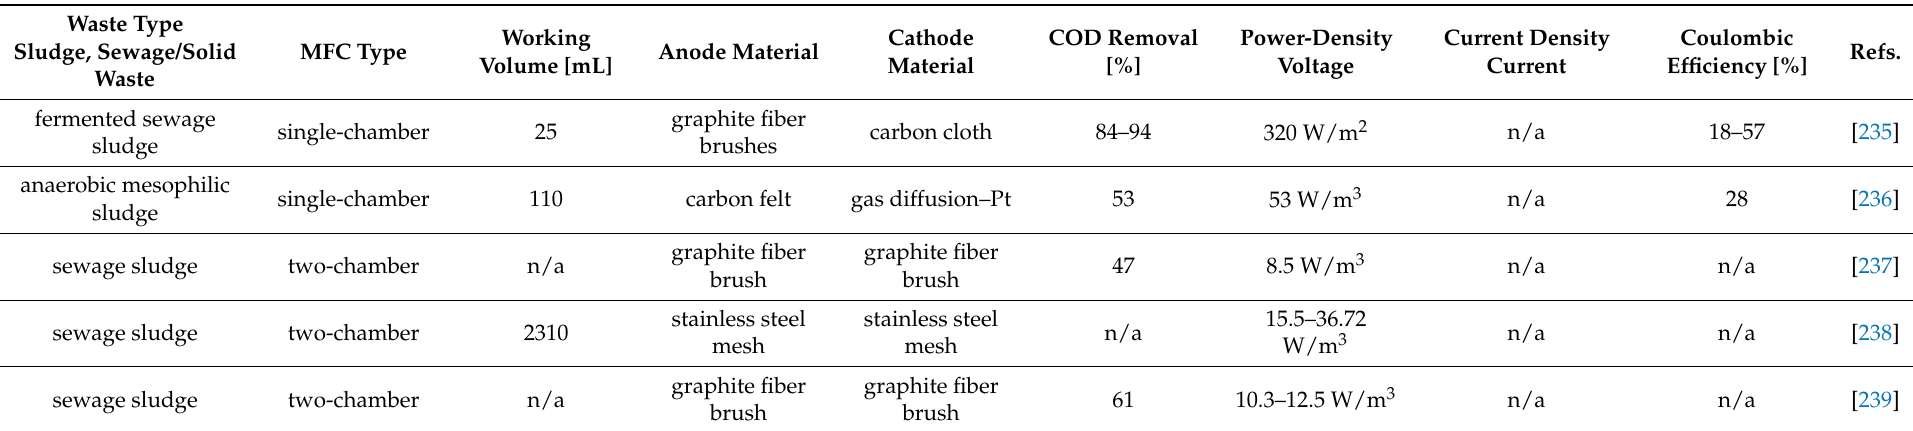
Table A9. Summary of studies reporting use of sludge, sewage, solid waste in